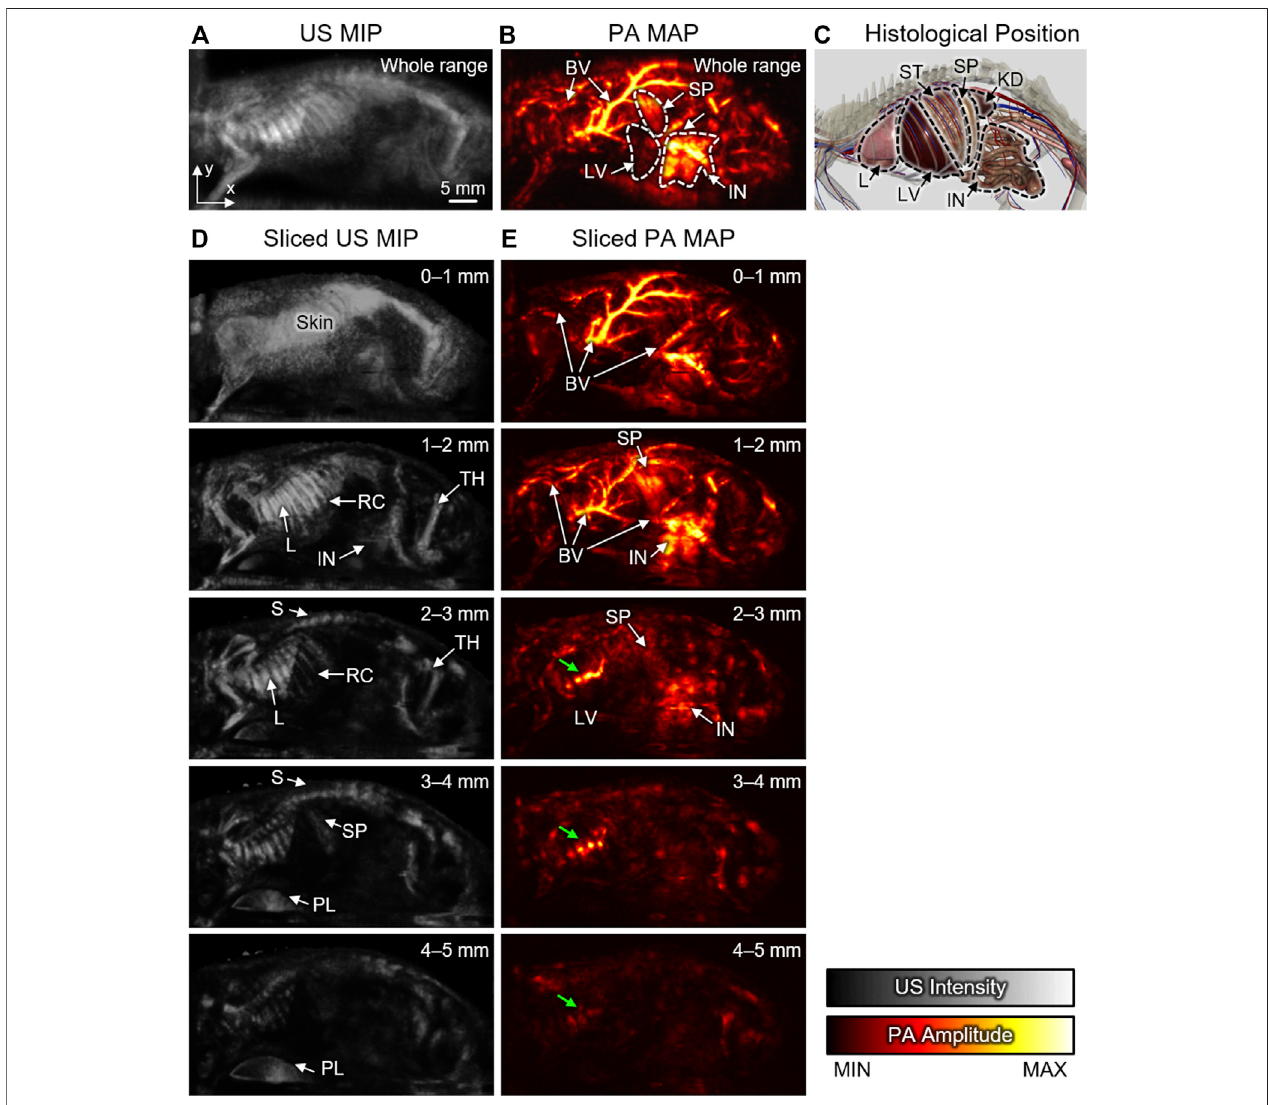
FIGURE3| SlicedUSMIPandPAMAPimagesfromtheleftsagittalviewwithdifferentrangesofdepth.Whole-range (A) USMIPand (B) PAMAPimagesinthex-y plane. (C) Histological positions of organs captured from the 3D anatomy software. Sliced (D) US MIP and (E) PA MAP images from the sectioned layers at different rangesofdepth.Greenarrowsdenotere fl ectionartifactsbytheairinlung.US,ultrasound;PA,photoacoustic;MIP,meanintensityprojection;MAP,maximumamplitude projection; 3D, three-dimensional; BV, blood vessel; L, Lung; LV, Liver; S, spine; ST, stomach; SP, spleen; IN, intestine; KD, kidney; RC, rib cage; TH, thigh; PL,